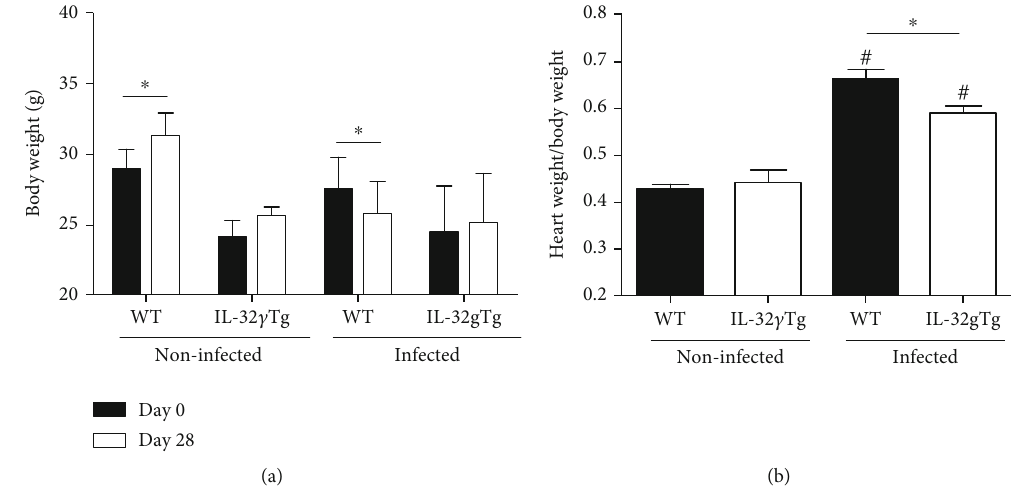
Figure 2: Body and heart weight of WT and IL-32 γ Tg mice noninfected or infected with the Colombian strain of T. cruzi in the acute phase of experimental Chagas disease. (a) Body weight evaluated on day 0 and day 28 of infection. ∗ p < 0 : 05 (day 0 vs. day 28, two-way ANOVA test). (b) Heart weight and body weight ratio of noninfected and infected WT and IL-32 γ Tg mice (%). # p < 0 : 05 (di ff erences within the same animal group) and ∗ p < 0 : 05 (WT vs. IL-32 γ Tg mice; two-way ANOVA test with Bonferroni post hoc